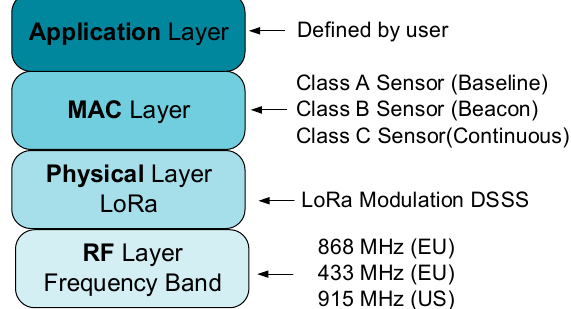
Figure 2. The LoRaWAN communication stack.